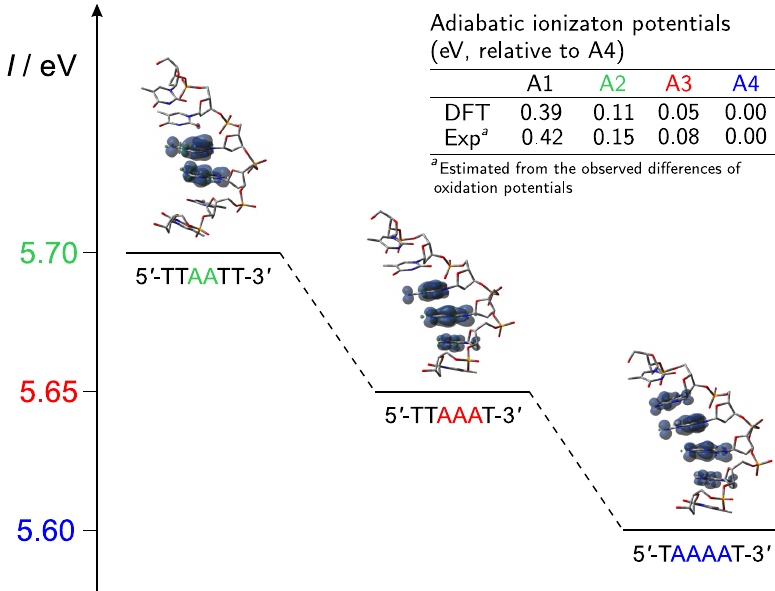
Figure 7. Predicted adiabatic ionization potential and spin densities for the 5 (cid:48) -TTAATT-3 (cid:48) (A2), 5 (cid:48) -TTAAAT-3 (cid:48) (A3), and 5 (cid:48) -TAAAAT-3 (cid:48) (A4) single stranded ionized oligonucleotides. Inset: Comparison between relative computed ionization energies and observed oxidation free energies. The lowering of the oxidation potential observed for sequences lacking G upon increasing the number of stacked adenines has been rationalized in terms of resonance effects: the increasing stability of the hole is due to its delocalization over the entire adenine bridge. Adapted from Ref. [85] with permission from the PCCP Owner